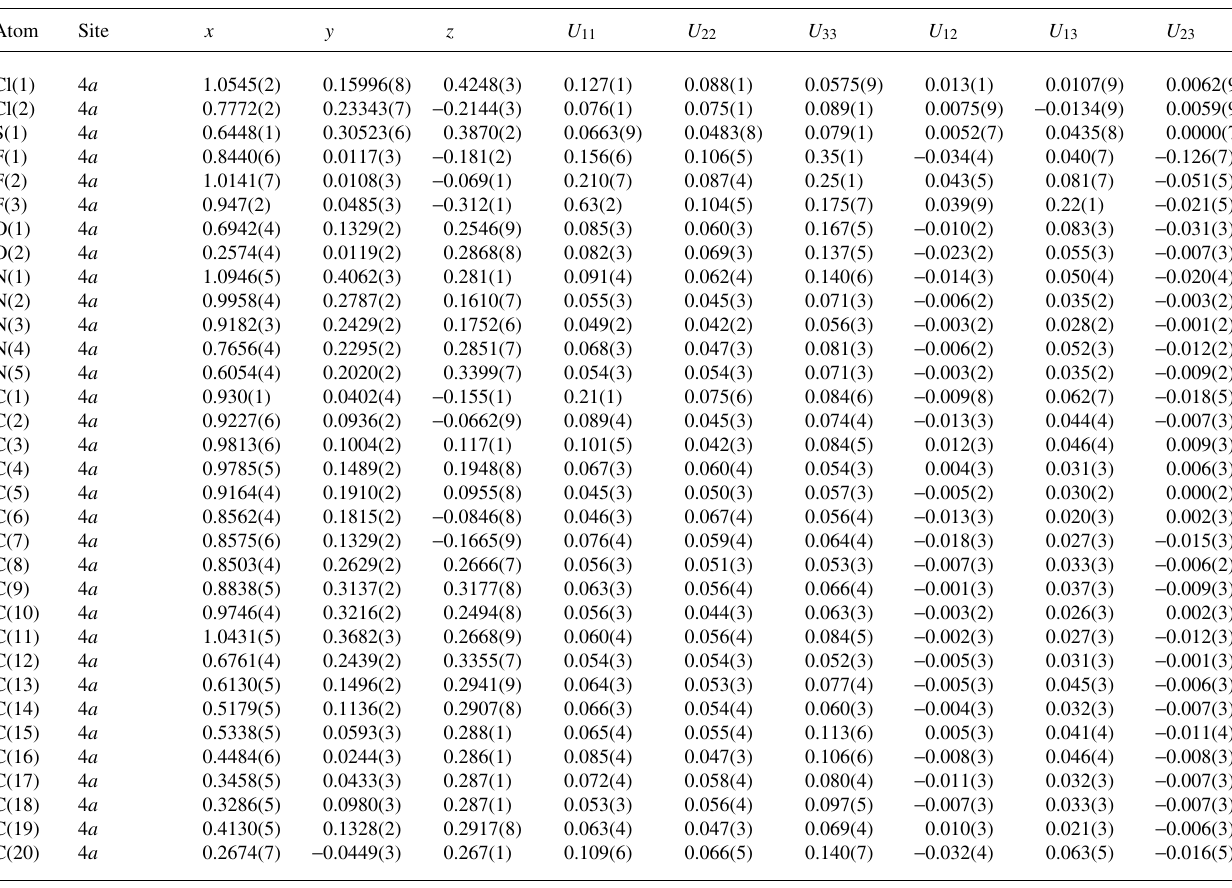
Table 3. Atomic coordinates and displacement parameters (in Å 2 ) .